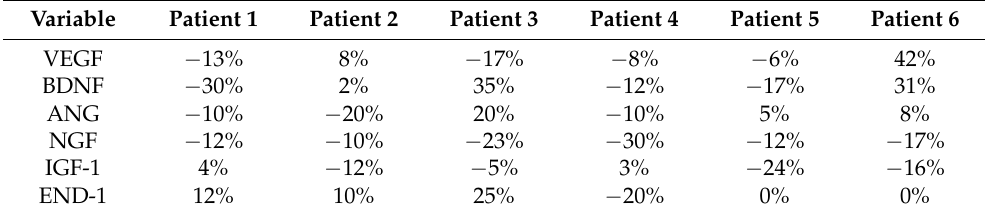
Table 5. Percentage variation of neurotrophic and growth factors compared to the baseline (T0).